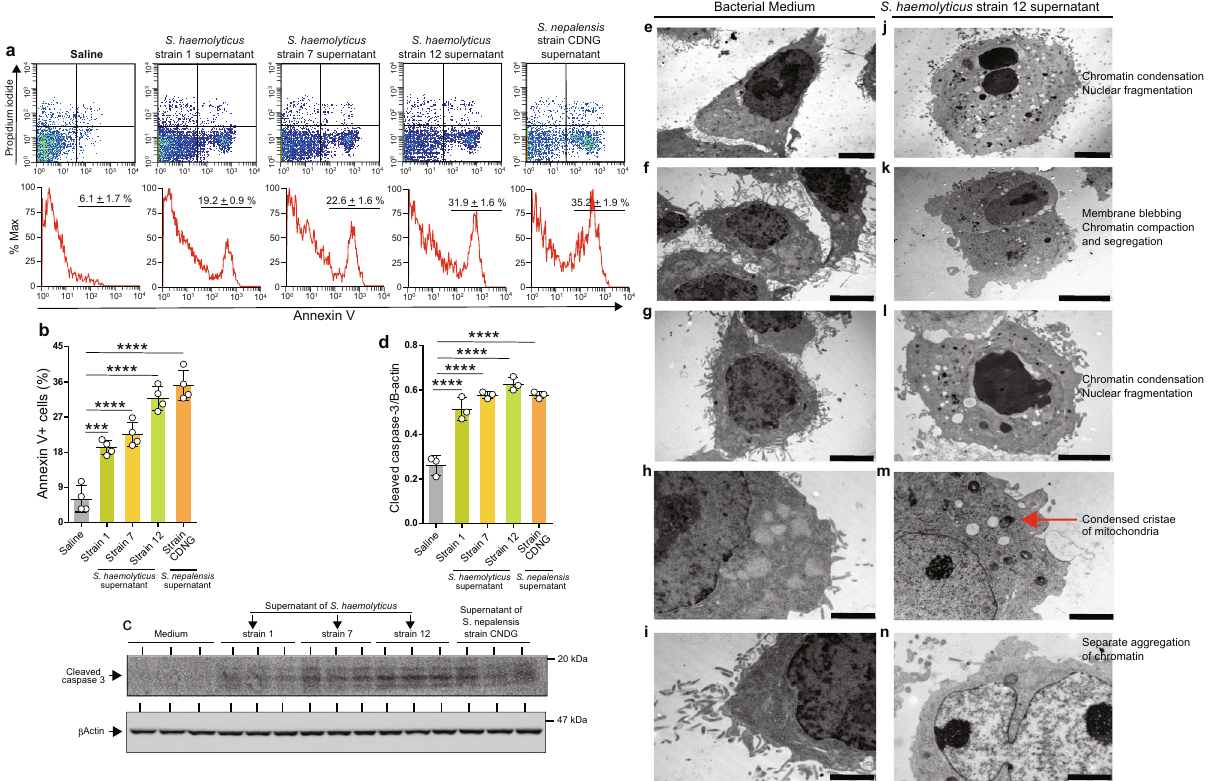
Fig. 1 The culture supernatants from three strains of S. haemolyticus induce apoptosis of alveolar epithelial cells. a A549 alveolar epithelial cells were cultured in the presence of the (1/10 dilution) culture supernatants from strains 1, 7, and 12 of S. haemolyticus for 48 h. A549 cells treated with the culture supernatant from S. nepalensis strain CNDG were the positive controls and cells treated with saline were the negative controls. b The percentage of apoptotic cells was determined by fl ow cytometry and quanti fi ed. N = 4 in each group. Data are expressed as the mean ± S.D. Statistical analysis was performed using ANOVA with a post hoc Newman – Keuls test. *** p < 0.001; **** p < 0.0001. c , d Western blotting of A549 cells cultured in the presence of the culture supernatants of the three S. haemolyticus strains and S. nepalensis . In ( d ) n = 3 in each group. Representative blots from two independent experiments with similar results are shown. Data are expressed as the mean ± S.D. Statistical analysis was performed using ANOVA with a post